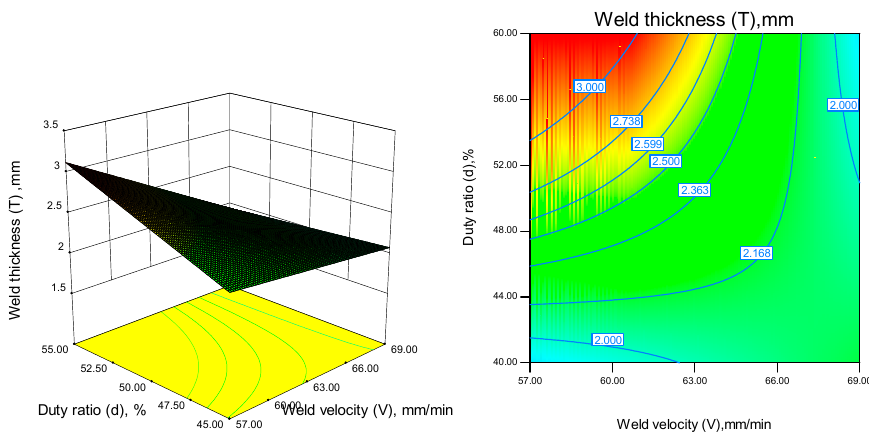
Figure 18. Interaction of peak current and welding position on weld depth.